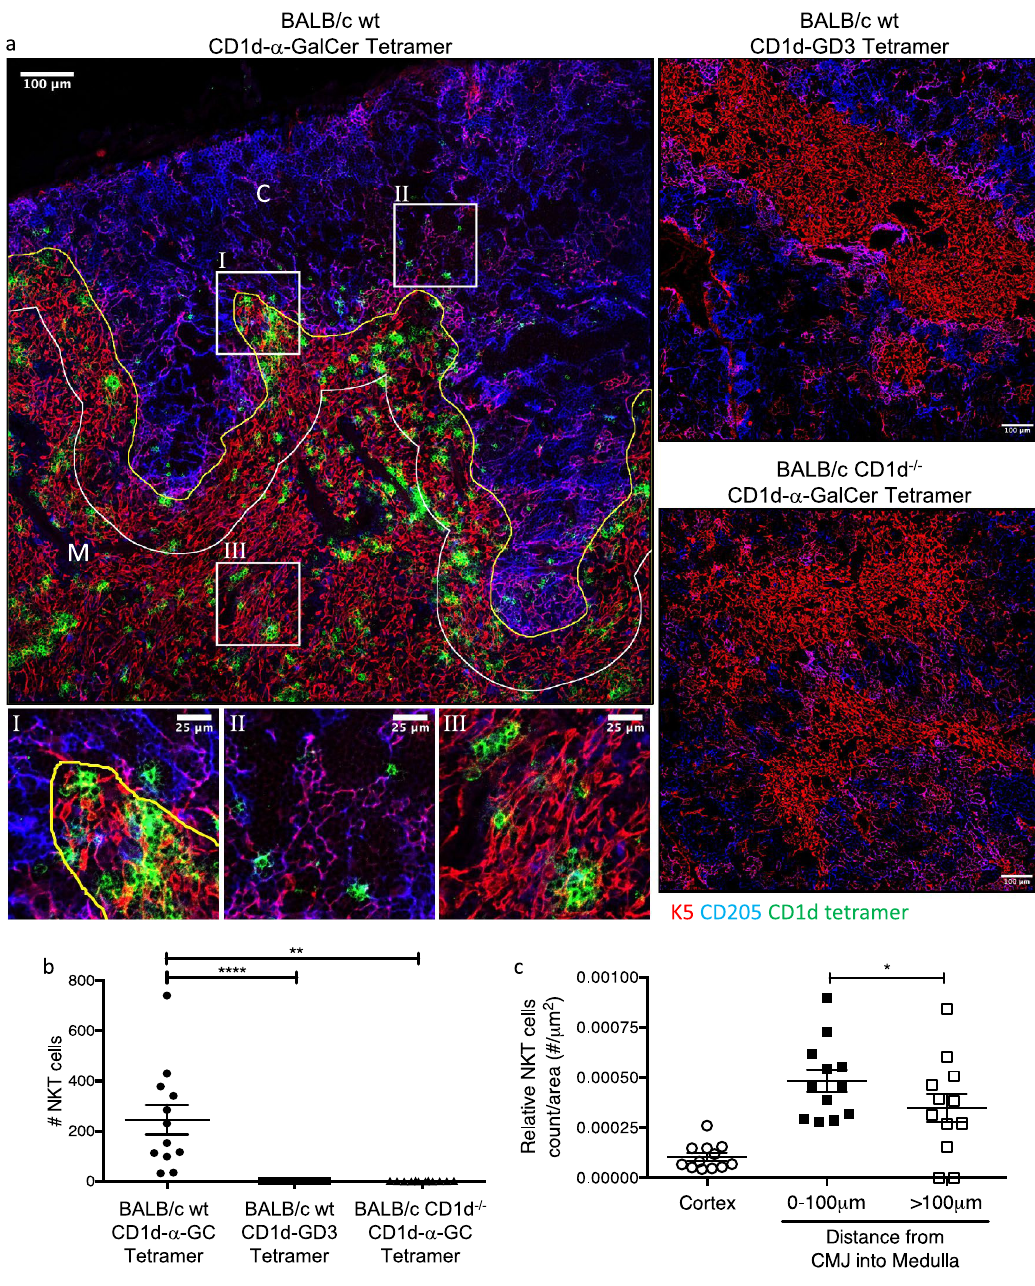
Figure 3. Distribution of NKT cells within the mouse thymus. Thymus sections from BALB/c WT mice stained with α-GalCer or GD3 loaded CD1d tetramers and anti-CD205 and cytokeratin-5 or anti-CD4 and CD3 antibodies. ( a ) Representative image showing CD1d-α-GalCer tetramer (green), CD205 (blue) and cytokeratin-5 (red) staining within thymic cortex (C) and medulla (M). White line within medulla shows distance 100 μm from corticomedullary junction. ( b ) Total count of NKT cells per 0.63 mm 2 image, Friedman test with Dunn’s comparison, and ( c ) proportion of NKT cells within each thymic region, Wilcoxon test. ( d ) Representative FACS plot and histogram showing percentage of NKT cells of total T cells and CD4 expression on NKT cells. Thymocytes were CD24 depleted and gated on live B220 − lymphocytes, Tet = Tetramer. ( e ) Representative image with corresponding zoomed regions of showing CD4 (red) and CD1d-α-GalCer tetramer (green). ( f ) Representative image of CD4 + (purple) or CD4 − (green) NKT cells as determined by colocation analysis, CD3 (gray). ( g ) Mean proportion of CD4 + to CD4 − NKT cells within each thymic region, two-way ANOVA with Sidak post-hoc test. Image scale bar 100 μm with corresponding zoomed regions of interest, scale bar 25 μm. Microscopy images acquired with Zen 2012 (ZEISS ZEN Microscope Software for Microscope Components) and processed with FIJI/ImageJ (Fiji (imagej.net)) and Imaris 9.3 (Microscopy Image Analysis Software—Imaris—Oxford Instruments (oxinst.com)) and figure compiled with Microsoft PowerPoint (Microsoft PowerPoint Slide Presentation Software|Microsoft 365). Data n = 8 mice combined from 2 independent experiments, mean ± SEM, * = p <